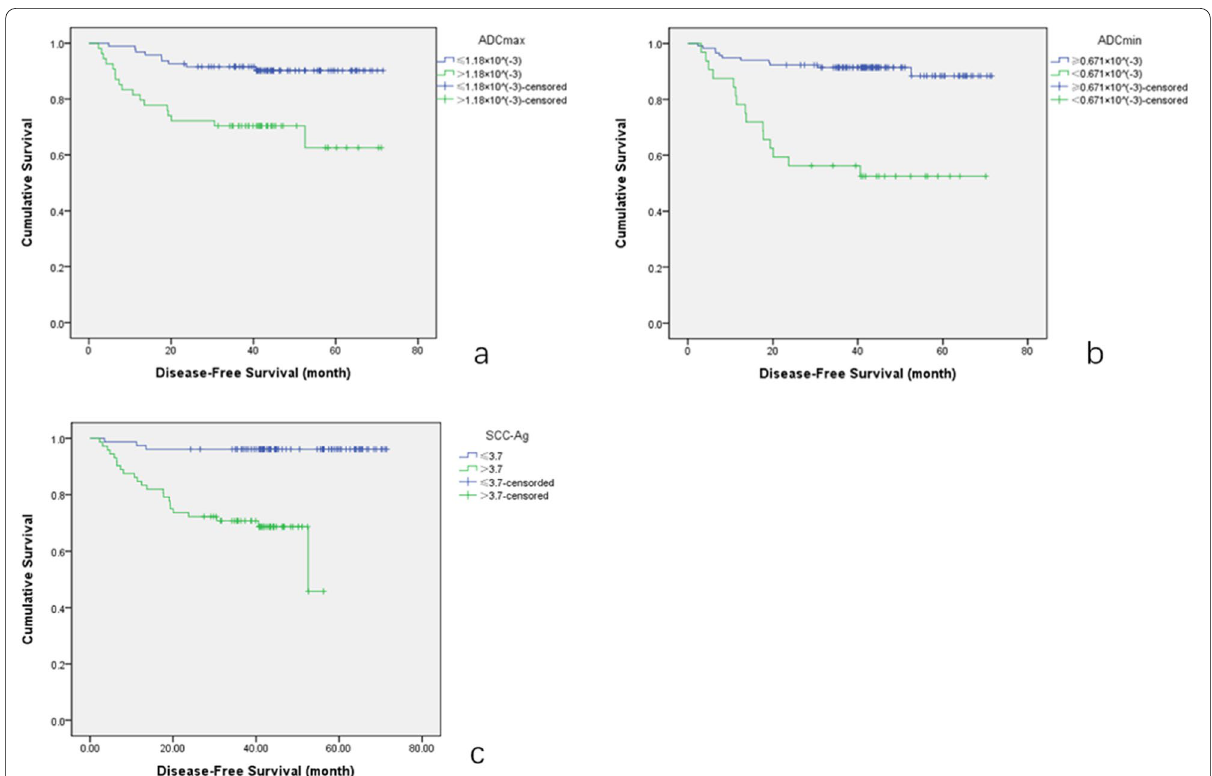
Fig. 5 DFS curves of patients in the entire patient group; a ADCmax of the primary tumor; b ADCmin of the primary tumor; c pretreatment SCC-Ag of patients. DFS, disease-free survival; ADC, apparent diffusion coefficient; SCC-Ag, squamous cell carcinoma